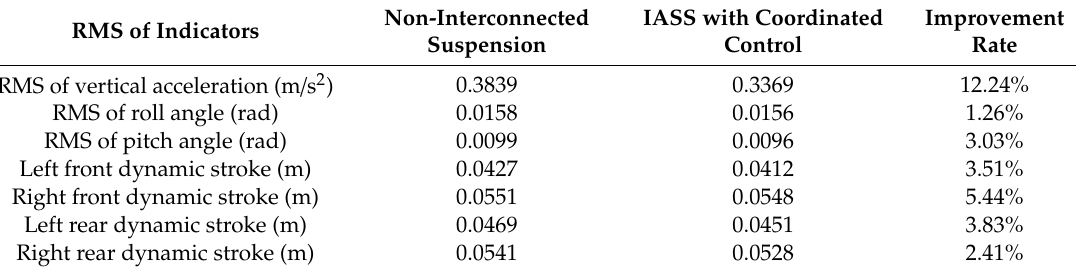
Figure 28. Dynamic stroke for front left suspension under the steering condition. Table 4. RMS value under the steady steering condition.